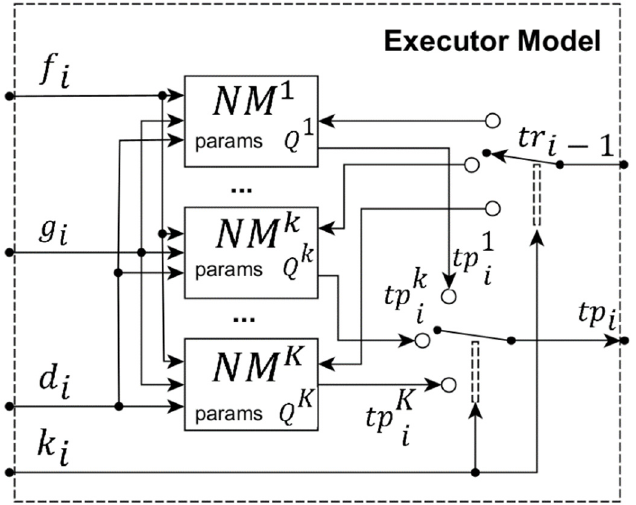
Figure 5. Executor model E diagram after taking into account the assumptions. NM k —designed neural network